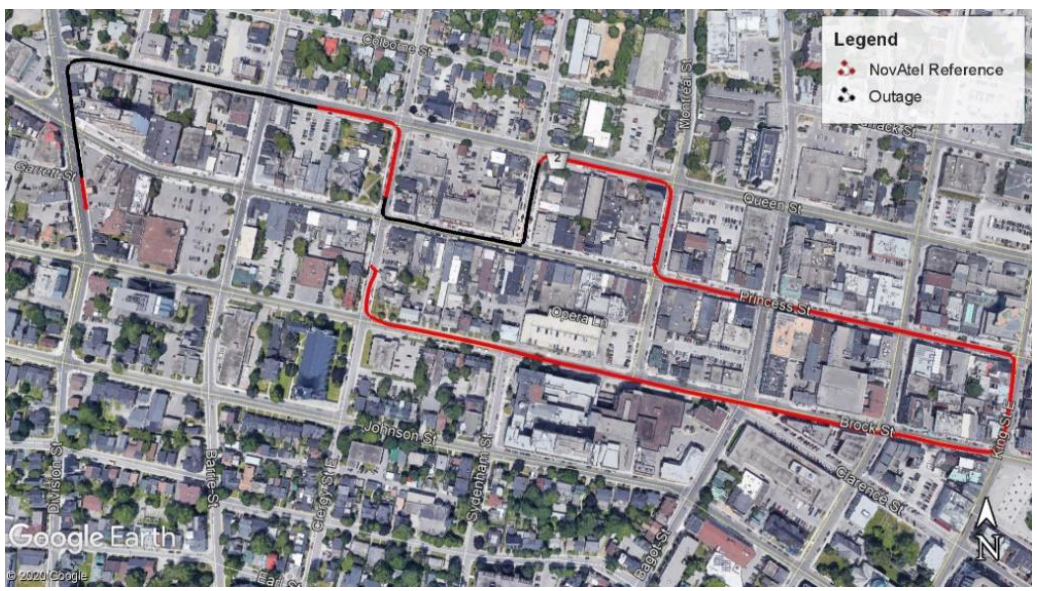
Figure 14. First Trajectory Highlighting the Simulated Outages.